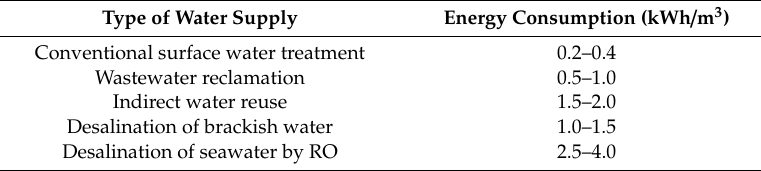
Table 2. Energy requirements for the production of water supply from di ff erent